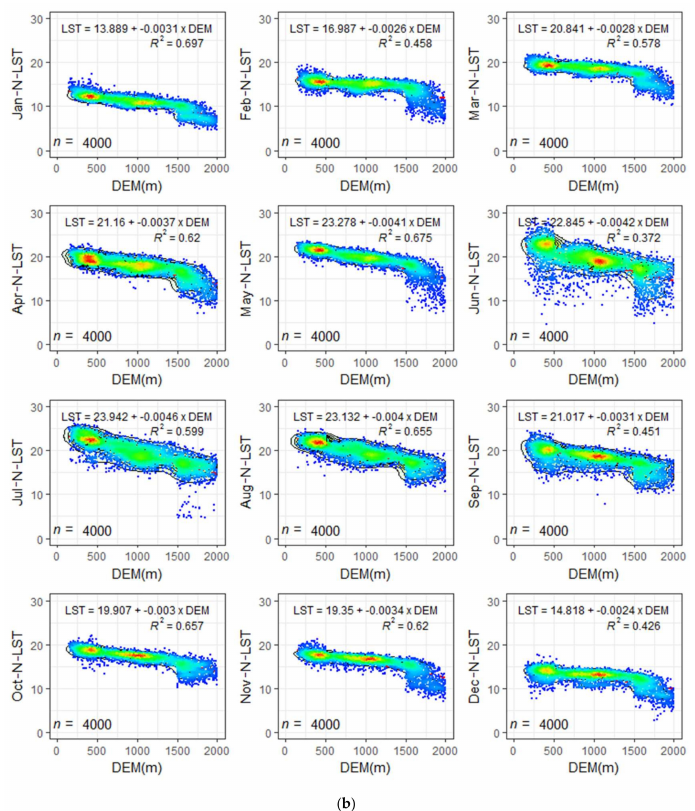
Figure 6. ( a ) Scatter plots showing the relationship between the average monthly daytime LST of a balanced number of observation-based elevations and the elevation in northwest Vietnam in 2015. ( b ) Scatter plots showing the relationship between the average monthly nighttime LST of a balanced number of observation-based elevations and the elevation in northwest Vietnam in 2015. The color ramp from blue to red expresses the point density from low to